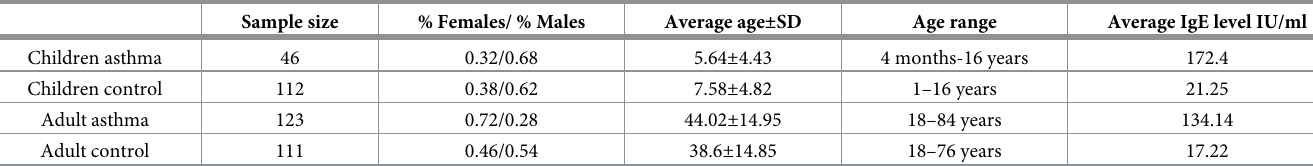
Table 1. Demographic characteristics of the study